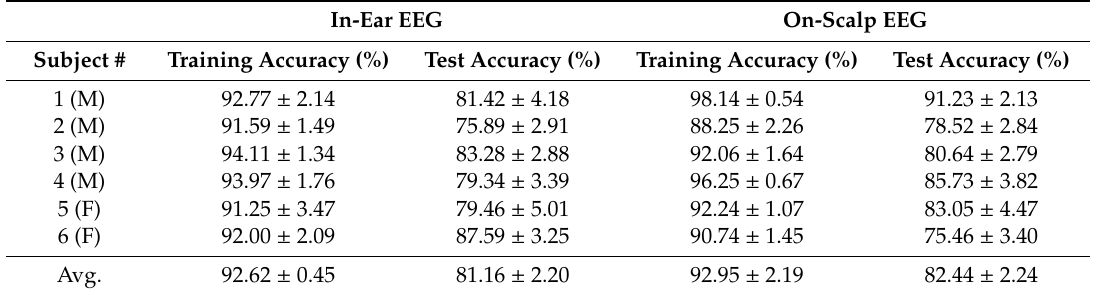
Table 2. The maximum training accuracy and test accuracy for each subject in the within-subject